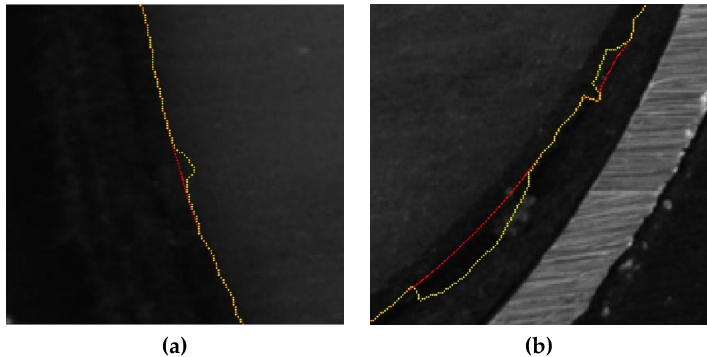
Figure 23. LTBC to detected mutations, in which yellow dots are initial closed contours and red dots are corrections. ( a ) LTBC to a detected P-Mutation in C 45 ; ( b ) LTBC to detected P-Mutations in C 56 .